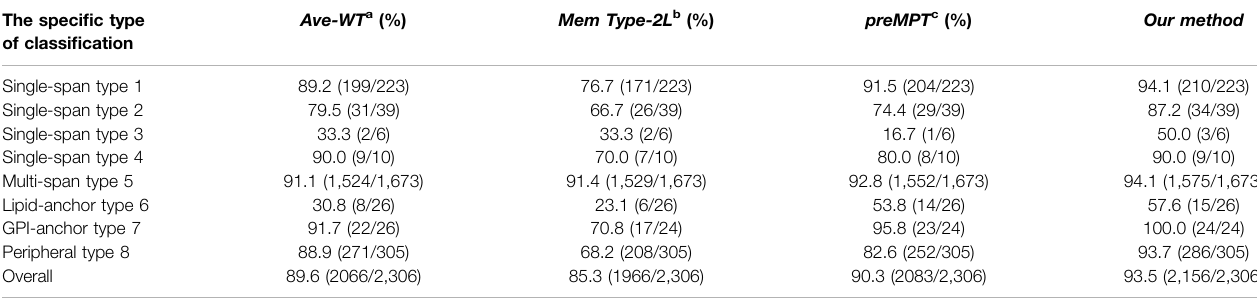
TABLE 3 | The performance exhibited by different models on dataset